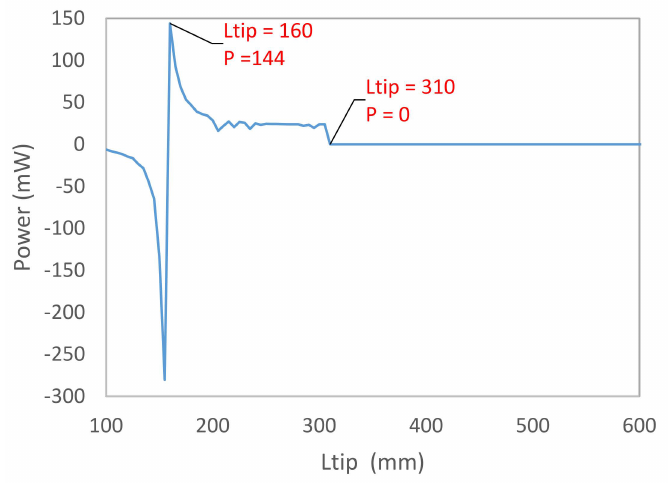
Figure 6. Graph Showing Variation of Power Output with Bluff Body Length L tip . The length of the cantilever beam L is changed between 40 mm and 400 mm with 2 mm steps. The same trend observed in the graph of L tip is seen for the parameter L in Figure 7, with the maximum observed at L = 90 mm. It is noteworthy that the mass of the cantilever beam also affects the deformation of the cantilever. In addition, for values of L exceeding 96 mm, the power produced is either negligible or the flow velocity is less than the onset velocity, which means that a higher water velocity is required for the higher mass model, to exert a hydrodynamic force capable of producing bluff body vibrations that cause sufficient piezoelectric deformation.